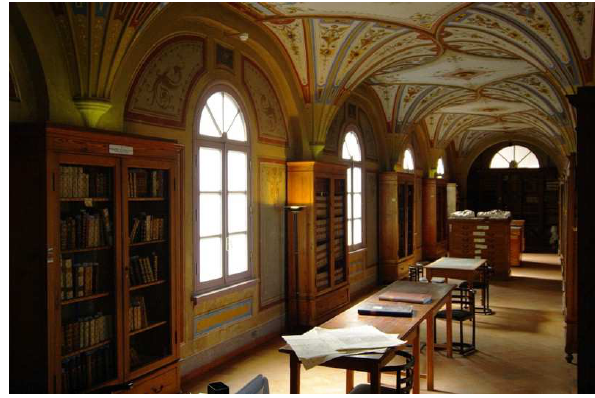
Fig. 6 Figure 6. The Library – “the Tacchini Gallery”.